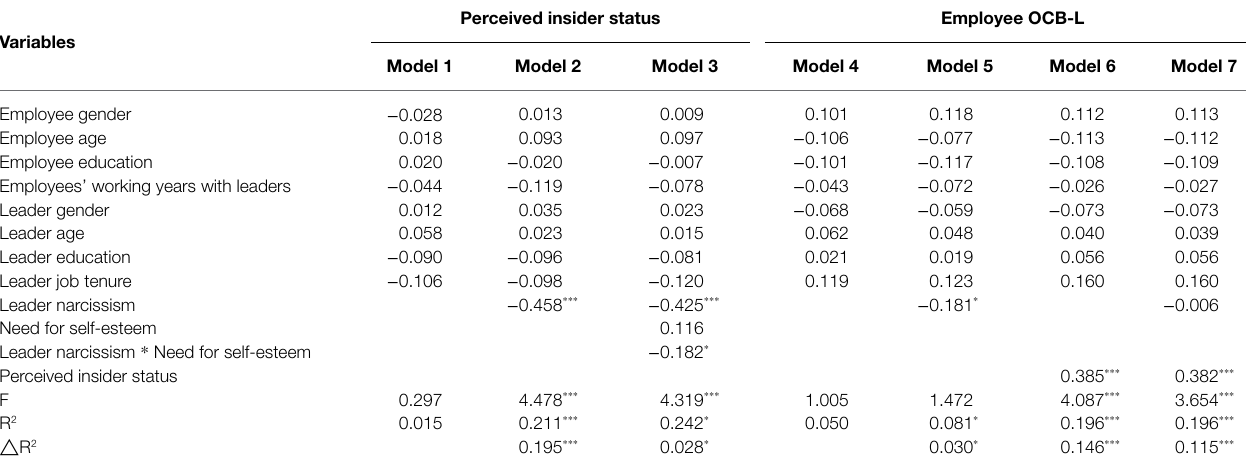
TABLE 3 | Regression analysis of hypotheses.